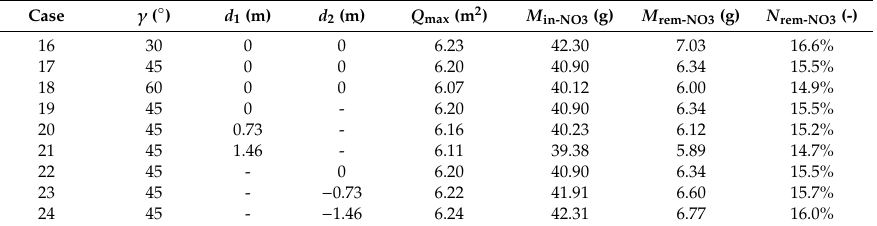
Table 6. Q max , M in-NO3 , M rem-NO3 and N rem-NO3 under di ff erent topography cases.